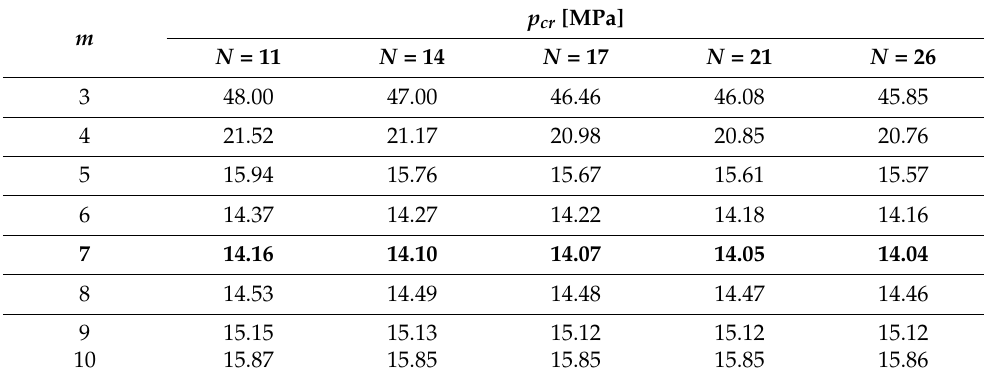
Table 3. Critical static load p cr of the composite plate model with Poisson’s ratio ν = − 0.3 for auxetic facings radially stretched on the inner edge versus a different numbers of discrete points N